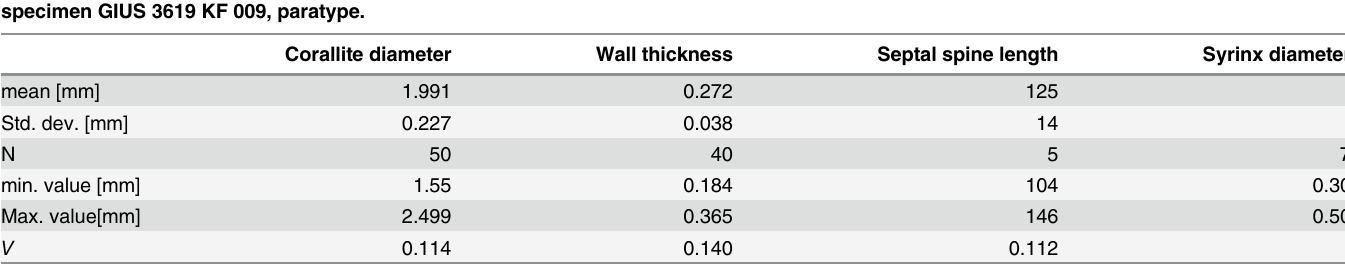
Table 3. Intracolonial variation in Syringopora kowalensis sp. nov. specimen GIUS 3619 KF 009,